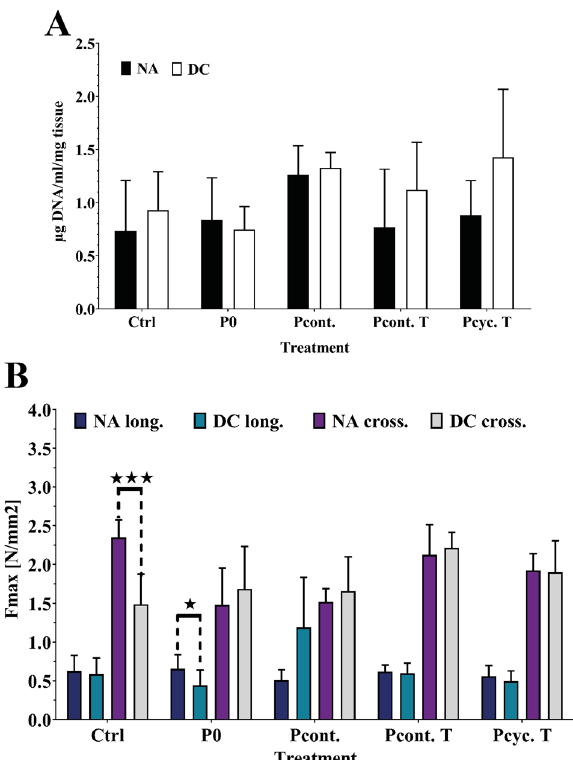
Fig. 6 Determination of tissue DNA concentration as well as evalua- tion of the mechanical properties of decellularized vs native tissue. A Shows the results of DNA quanti fi cation within native as well as decellularized aortic tissue. No difference in DNA content was observed between native and decellularized tissue. In ( B ) results of tensile strength tests are depicted as Fmax [N/mm 2 ] in circumferential and longitudinal orientation. Interestingly, this analysis revealed dif- ferences in in tensile strength of aortic tissue although decellularization was far from complete. (Numbers per group: Ctrl n = 7; P0/Pcont./ Pcont. T/Pcyc. T n = 5). * indicates p < 0.05, *** indicates p <